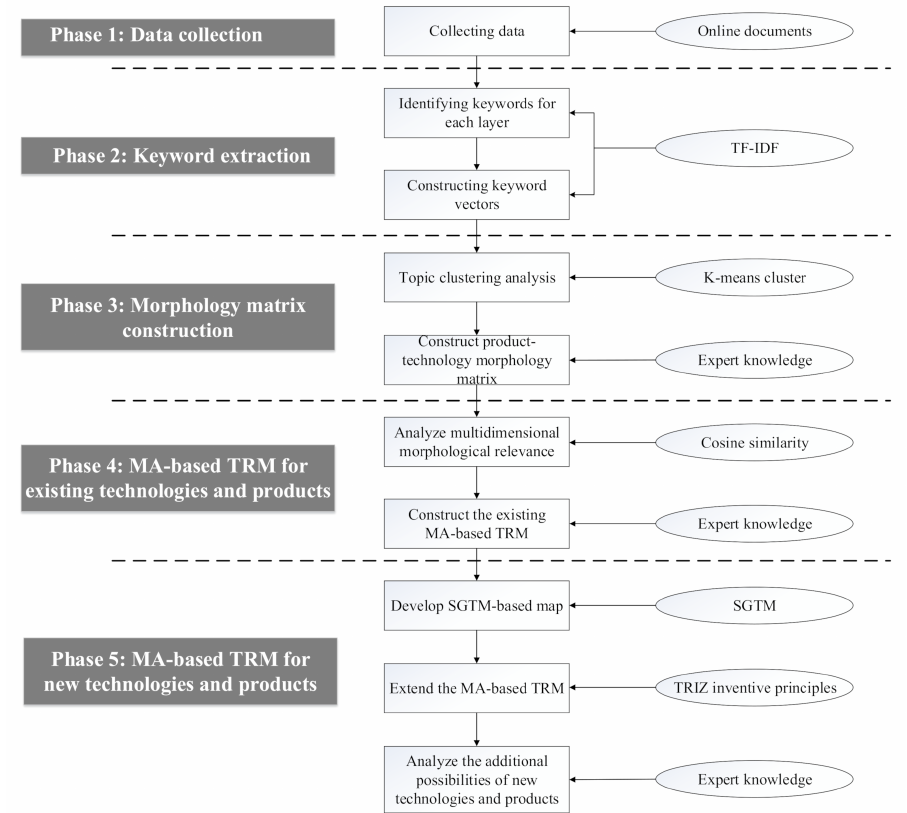
Figure 2. Research